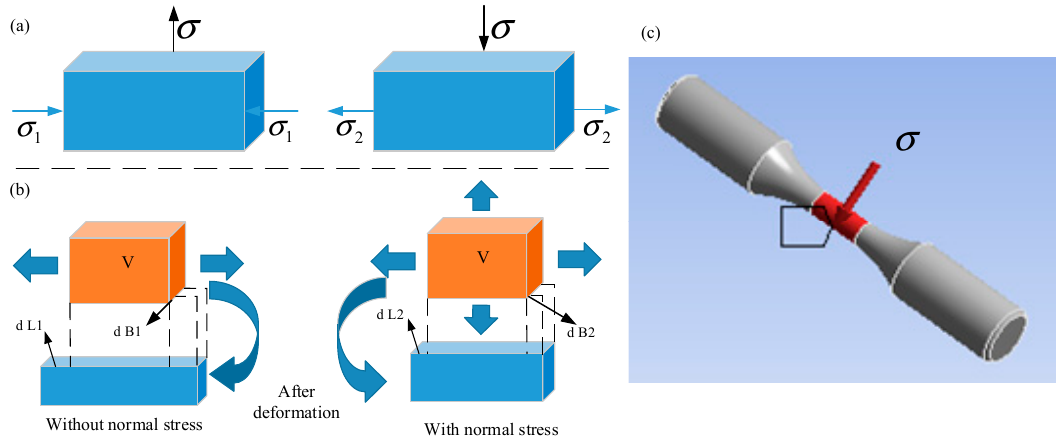
Figure 3. Residual stress simulation: ( a ) stress’s effect on the element; ( b ) deformation of the element; ( c ) model with normal stress on the middle surface.